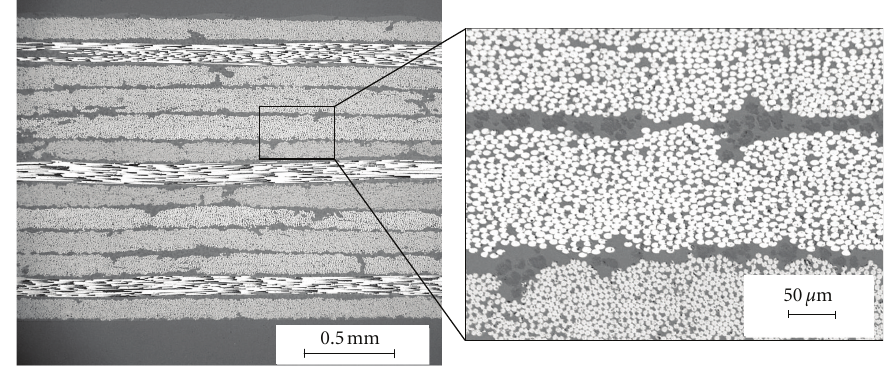
Figure 1: Micrograph of T800S/M21 composite laminate